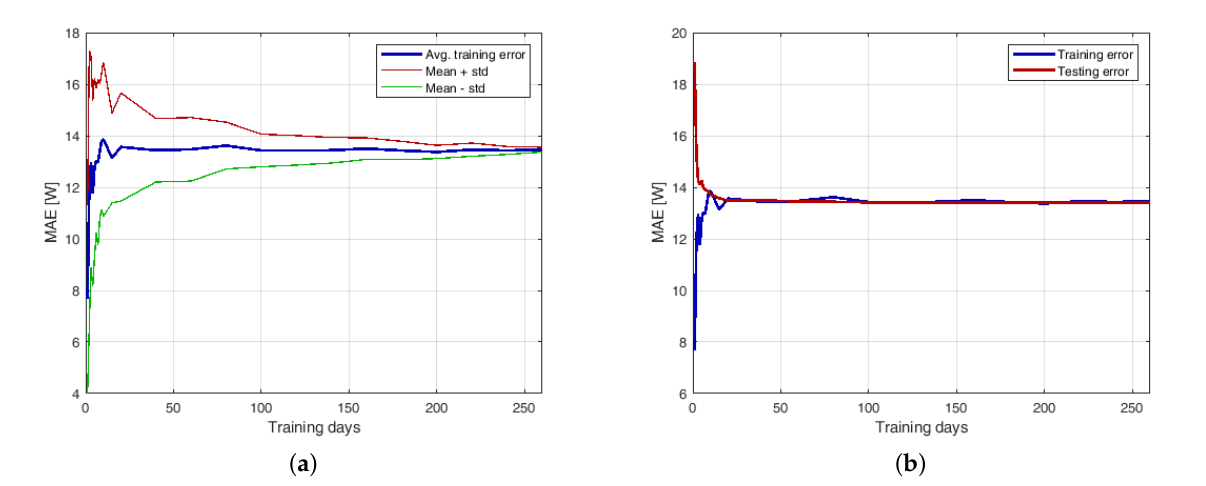
Figure 4. Effect of the selection of the training days. ( a ) Variability of the solutions: average value, first and third quartiles. ( b ) Learning curves, where each point is the average of 40 independent